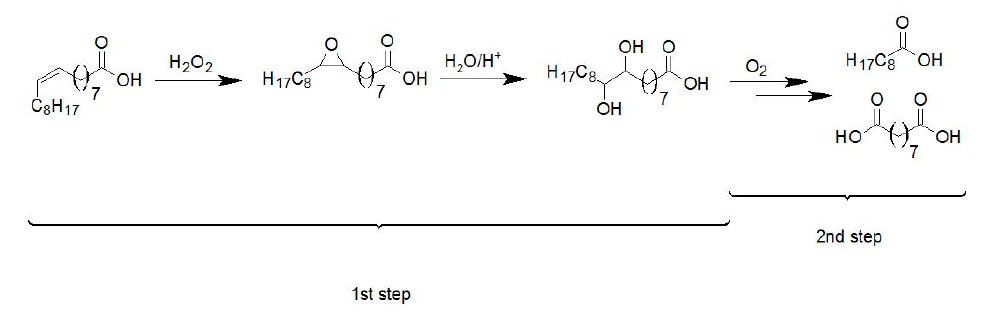
Scheme 3. Two-step oxidative cleavage of oleic acid.